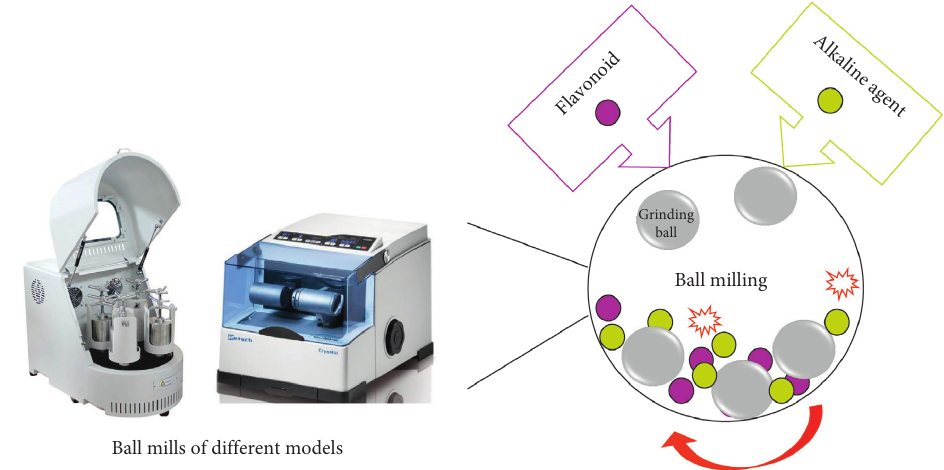
Figure 5: Second step of the extraction process by